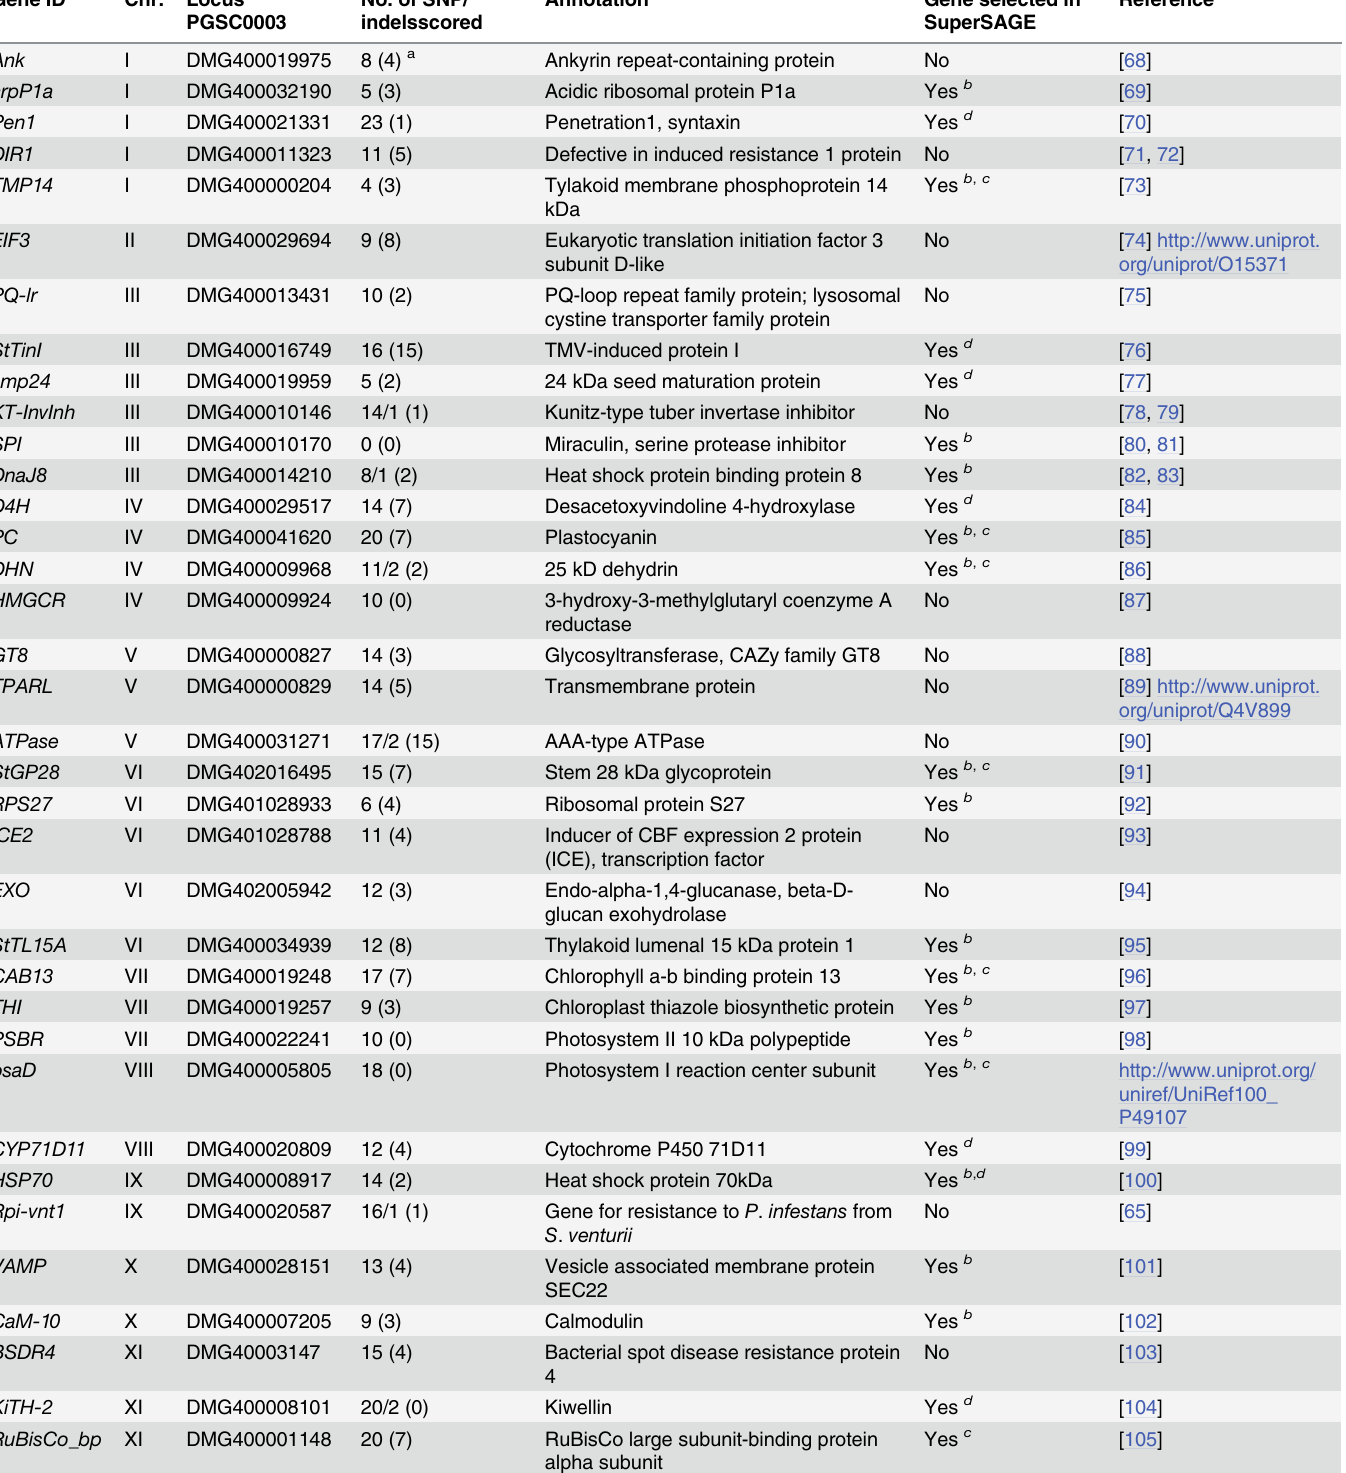
Table 4. Candidate genes with differential SNPs in RNA-Seq analysis that were selected for association analysis in the PIN184 population. Gene ID Chr. Locus